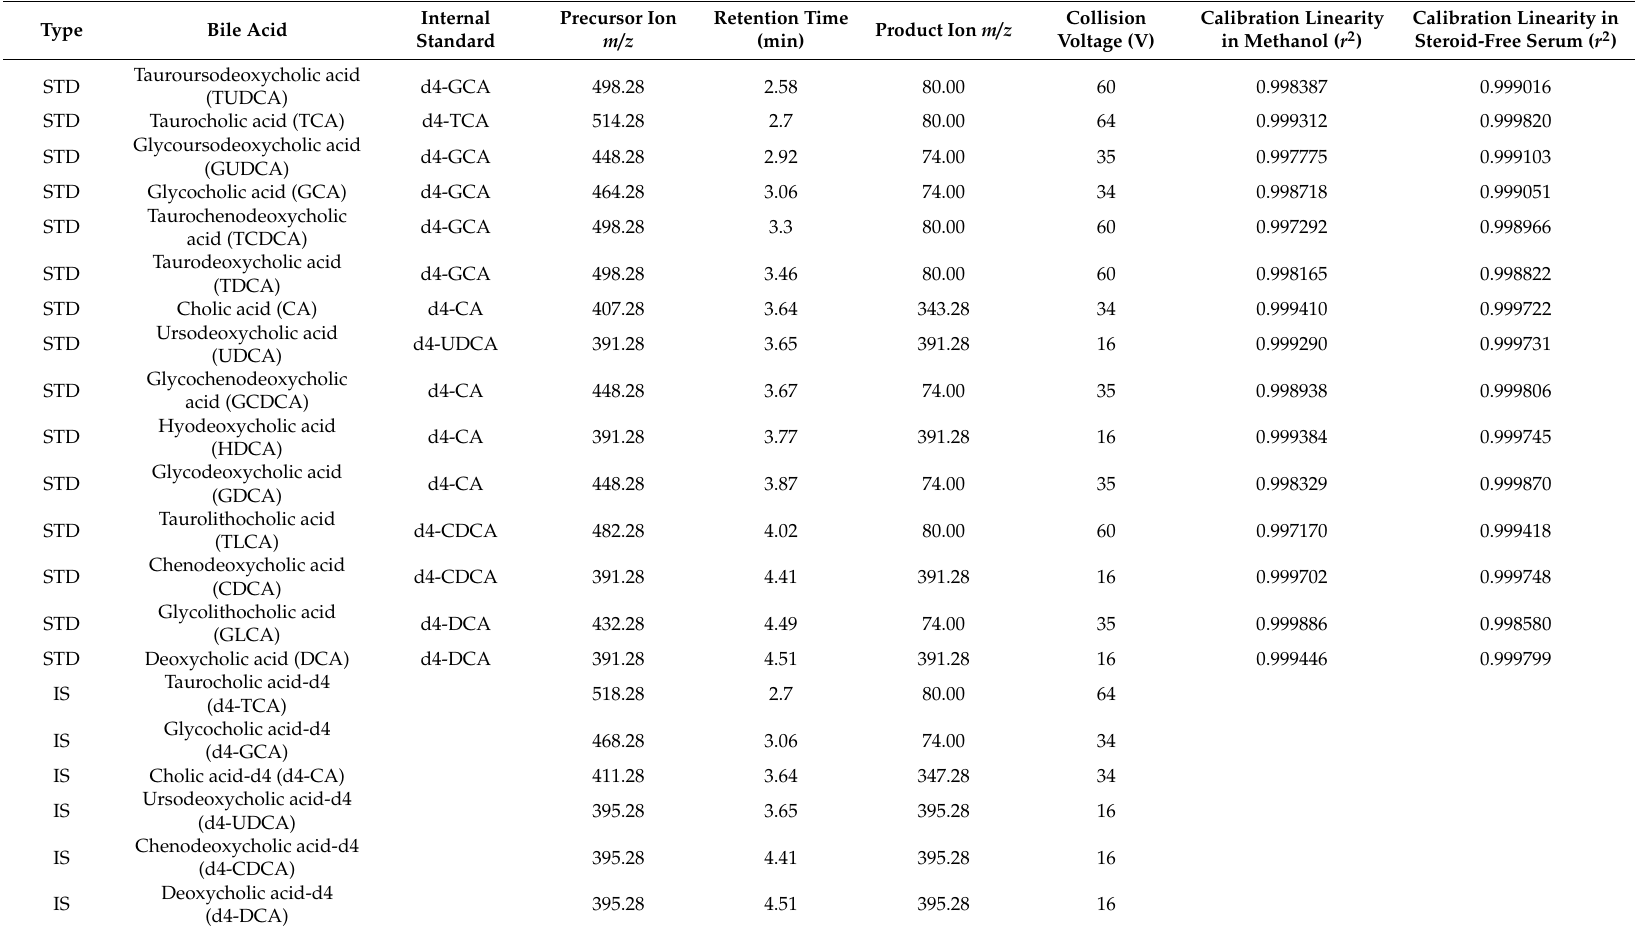
Table 1. Compound specific parameters and linearity results for each bile acid